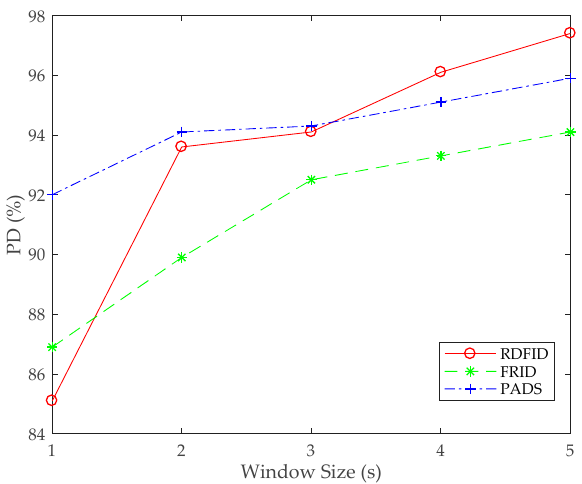
Figure 10. PD of human detection under different window sizes.